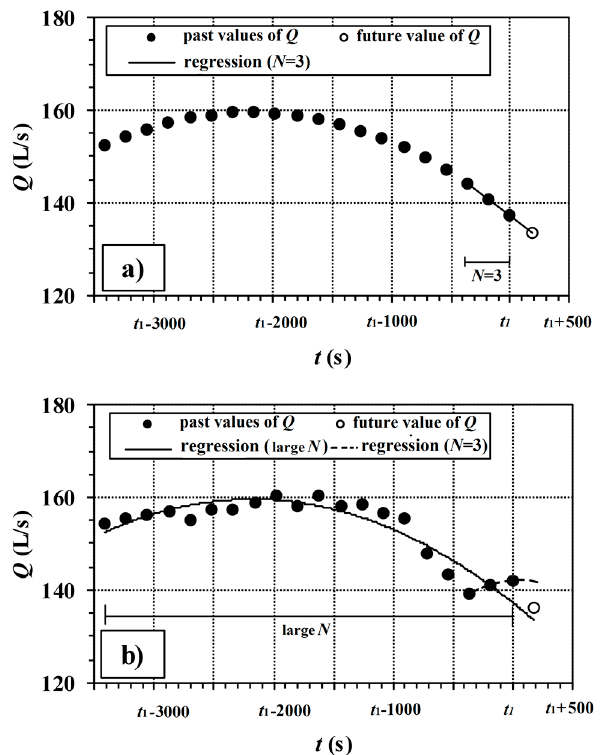
Figure 2. Example of application of the polynomial regression method for water discharge prediction in smooth ( a ) and irregular ( b ) demand trends.